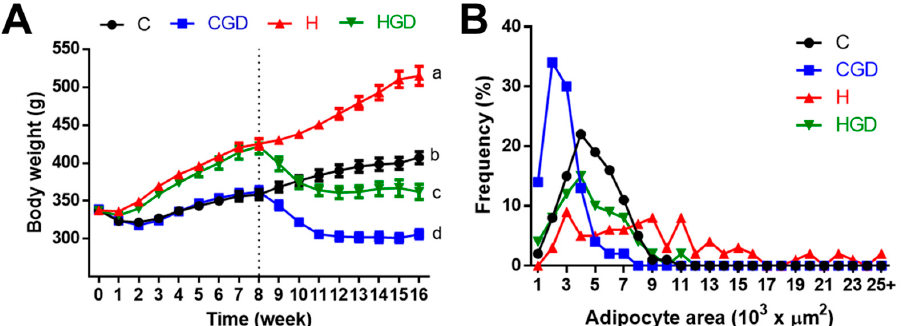
Figure 2. ( A ) Weekly body weight of C, CGD, H and HGD rats; dotted line signifies when treatment started for CGD and HGD rats, ( B ) Distribution of retroperitoneal adipocyte sizes. C, corn starch diet-fed rats; CGD, corn starch diet-fed rats supplemented with 5% Garcinia dulcis rind powder; H, high-carbohydrate, high-fat diet-fed rats; HGD, high-carbohydrate, high-fat diet-fed rats supplemented with 5% Garcinia dulcis rind powder.